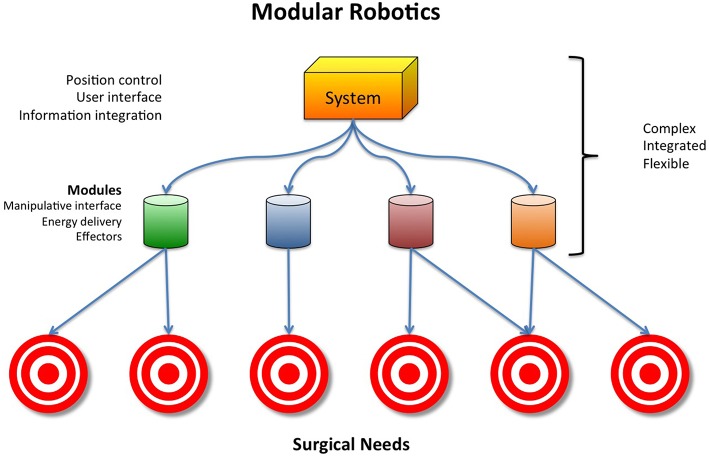
Modular robotics.